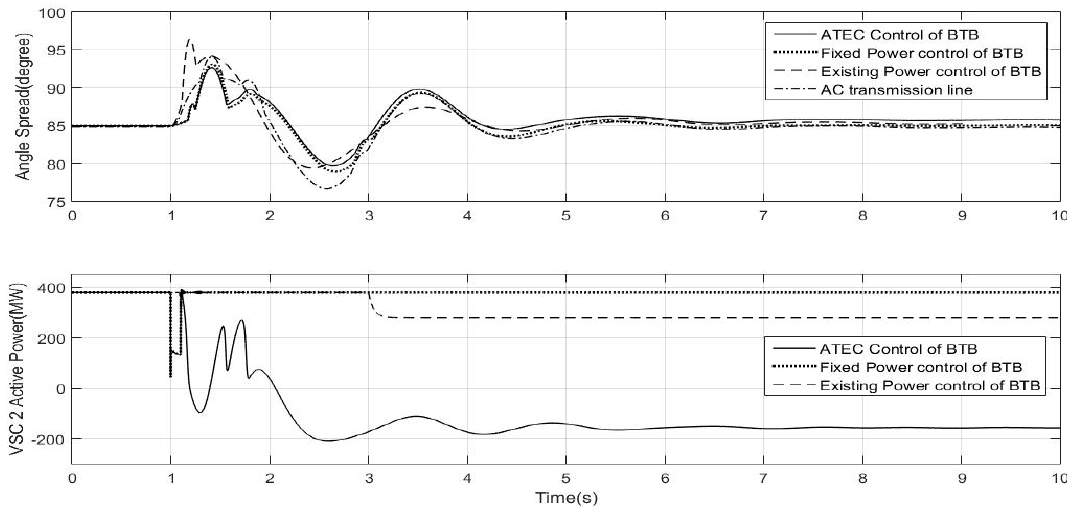
Figure 8. Angle spread and active power in the first ATEC strategy with a monitoring system.